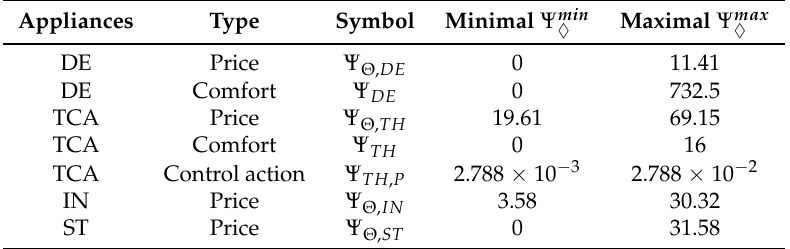
Table 6. The normalization coefficients calculated by the heuristic